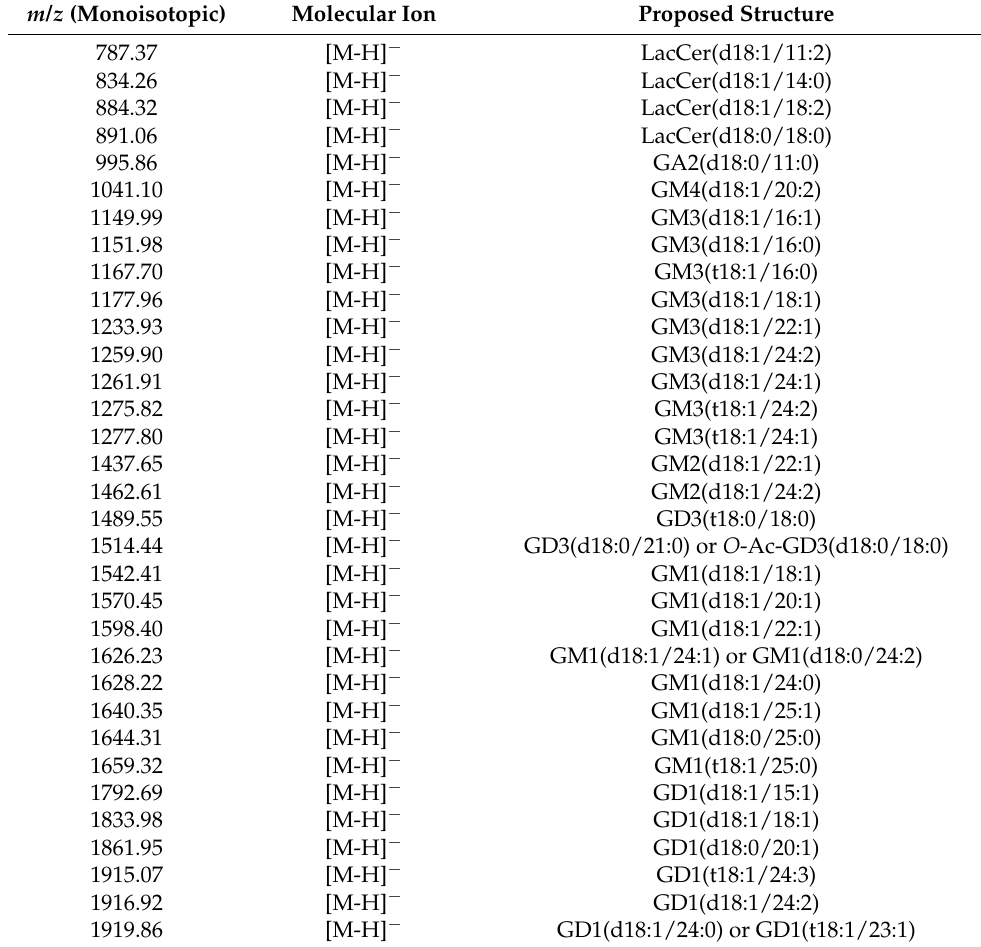
Table 2. Proposed composition of single components in the GG mixture from angioblastic menin- gioma specimen as detected by fully automated (-)nanoESIchip-QTOF MS (reprinted with permission from